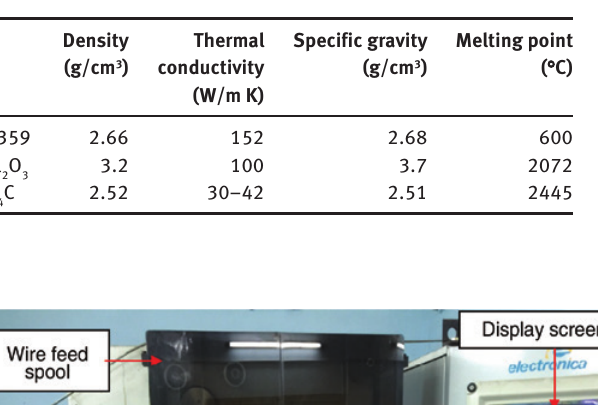
O , and B C. 2 3 4